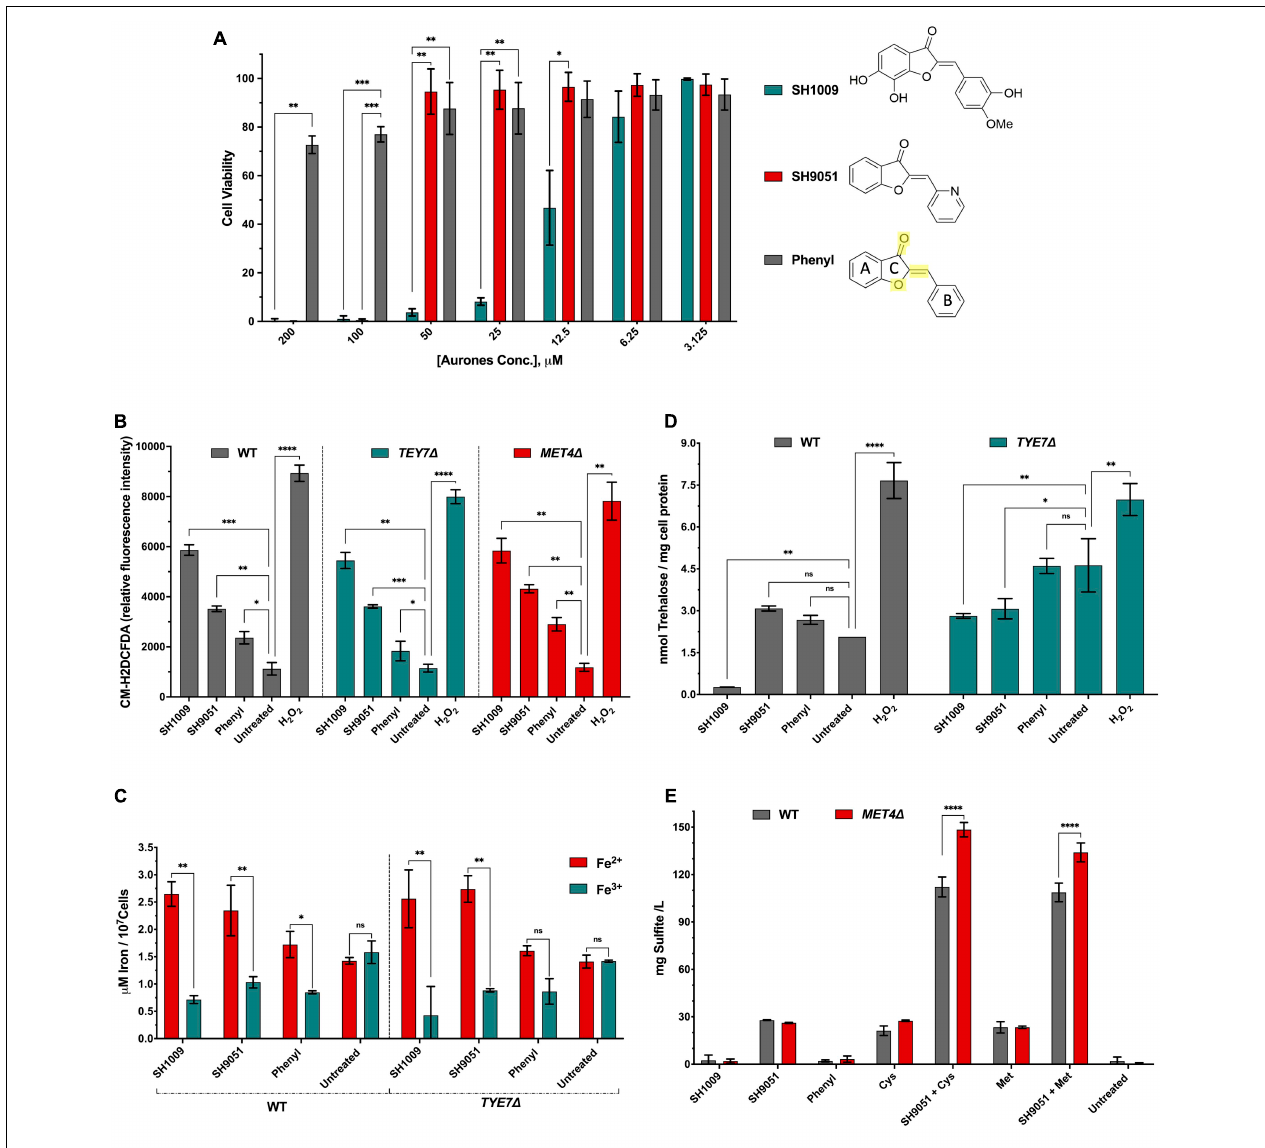
FIGURE 7 | Candida albicans cellular growth and metabolism responses to SH1009, SH9051, and phenyl aurones. (A) The inhibitory activity of SH1009, SH9051, and phenyl aurones on C. albicans SC5314 cell suspensions (0.5–2.5 × 10 3 CFU/mL) with treatments of two-fold serial dilutions of each aurone (3.125–200 µ M) in RPMI-1640 medium for 24 h at 35 ◦ C. PrestoBlue reagent was used to assay the cell viability. C ring structure is highlighted in yellow color in the phenyl aurone where the benzofuranone heterocyclic A and C rings are connected to the phenyl B ring by extended conjugation. (B) Changes in ROS production after 1 h treatment of 200 µ M of each aurone (H 2 O 2 was used as a positive control) on exponentially growing C. albicans SC5314, TYE7 (cid:49) , and MET4 (cid:49) cells in YPD media using the fluorescent dye CM-H 2 DCFDA. (C) Determination of intracellular ferrous (Fe 2 + ) ions in C. albicans SC5314 and TYE7 (cid:49) mutant cells based on the formation of a complex between Fe 2 + and an iron chromogenic substrate; ferric (Fe 3 + ) ions were determined using an iron reducer on separate samples to determine the total iron content and then subtracting the Fe 2 + ions from total iron to determine the Fe 3 + ion concentration. (D) The intracellular trehalose content of wild type C. albicans SC5314 and TYE7 (cid:49) at logarithmic phases were measured enzymatically following aurone treatment using trehalase coupled with Amplex red reagent as described in the “Materials and Methods” section. (E) Total sulfite production was measured in wild type C. albicans SC5314 and MET4 (cid:49) based on the reaction with Ellman’s reagent after treating cells with aurones and amino acids, 20 mM methionine or 10 mM cysteine. All data points are mean ± SD ( n = 3). Significances were calculated using two-way ANOVA for multiple comparisons. The asterisks indicate the difference was significant. P values: ( ∗∗∗∗ P ≤ 0.0001),